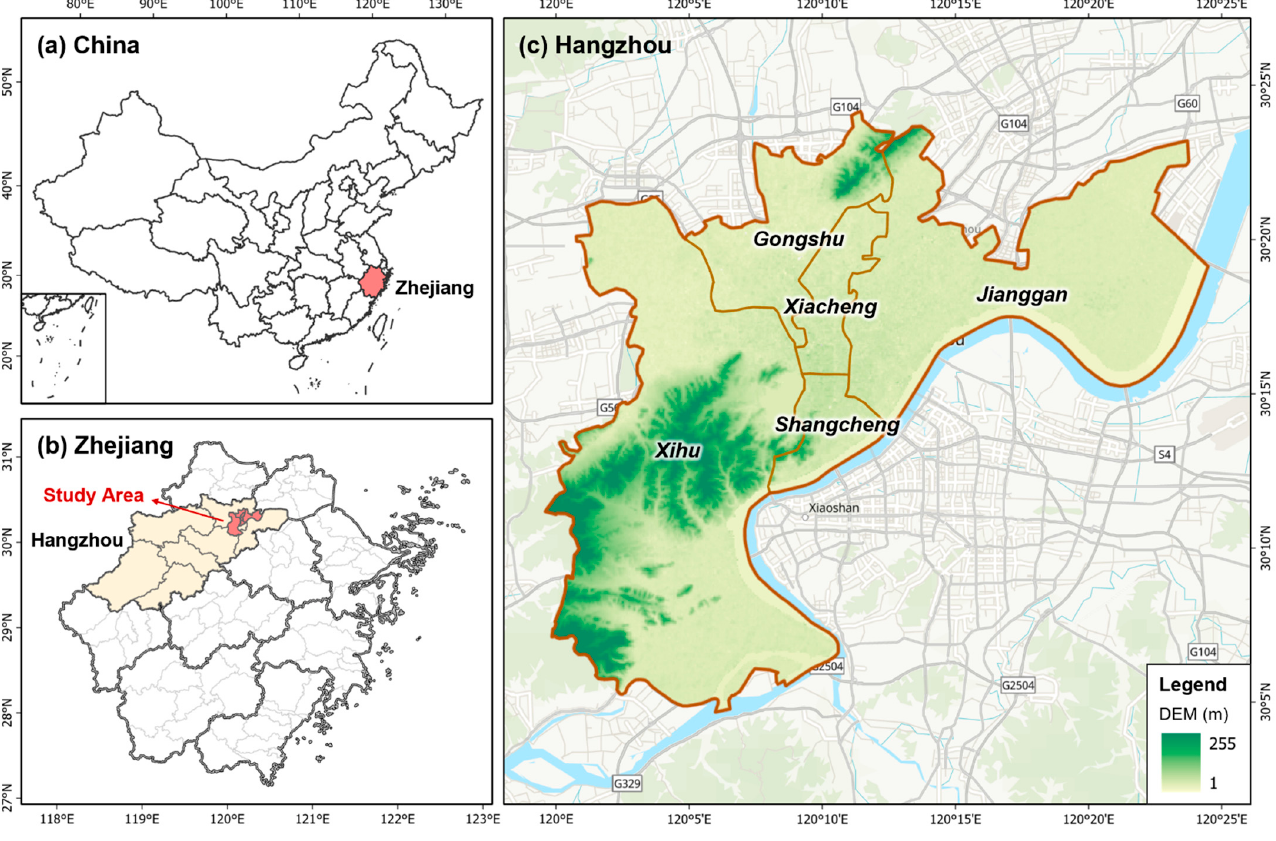
Figure 1. Study area. ( a ) The location of Zhejiang Province in China. ( b ) The location of Hangzhou in Zhejiang Province. ( c ) The location of study area in Hangzhou.